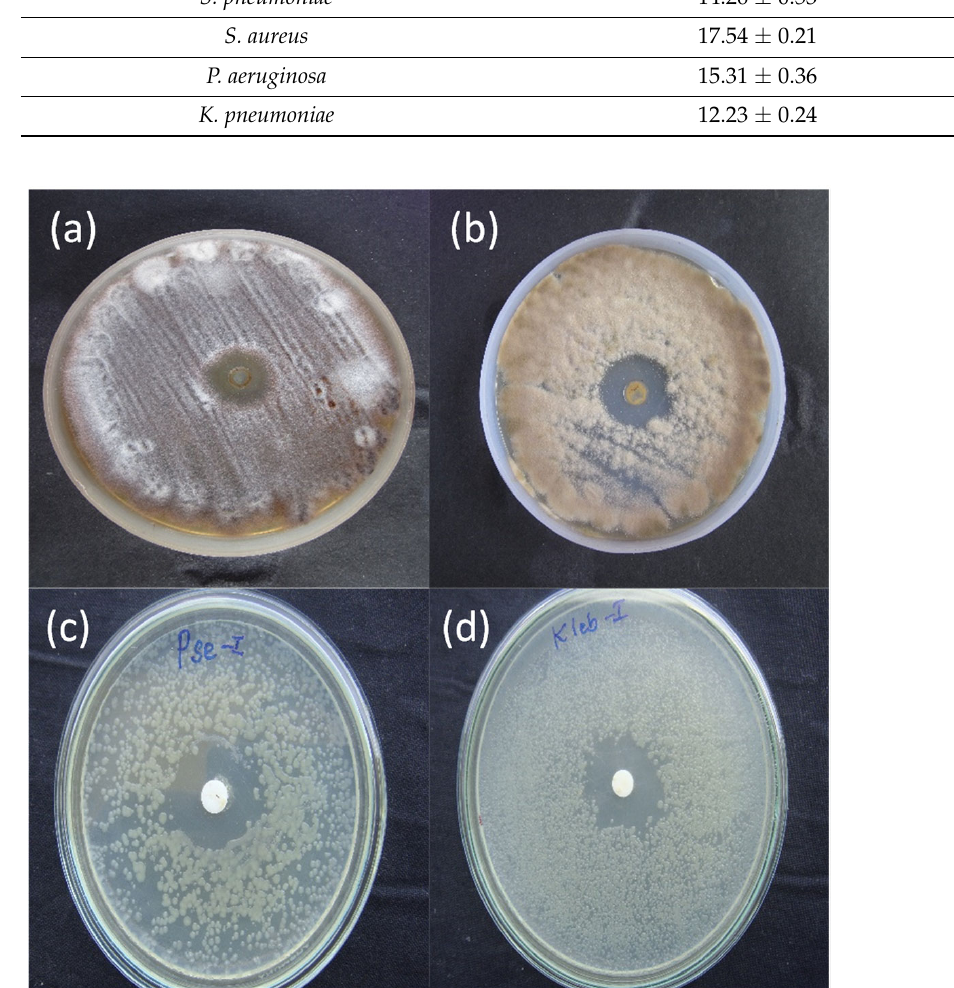
Figure 3. Inhibition zone obtained for BiONP ‐β‐ CD ‐ Biotin system against bacteria ( a ) S. pneumoniae ( b ) S. aureus ( c ) P. aeruginosa and ( d ) K. pneumoniae. Table 1. Result of the diameter of the inhibition zone observed for BiONP ‐β‐ CD ‐ Biotin system against bacteria.